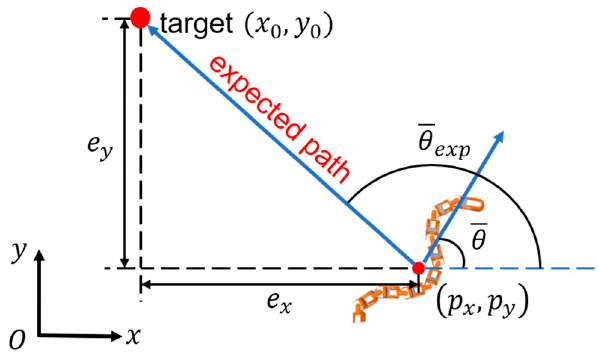
Figure 9. Schematic diagram of target tracking control of snake robot.